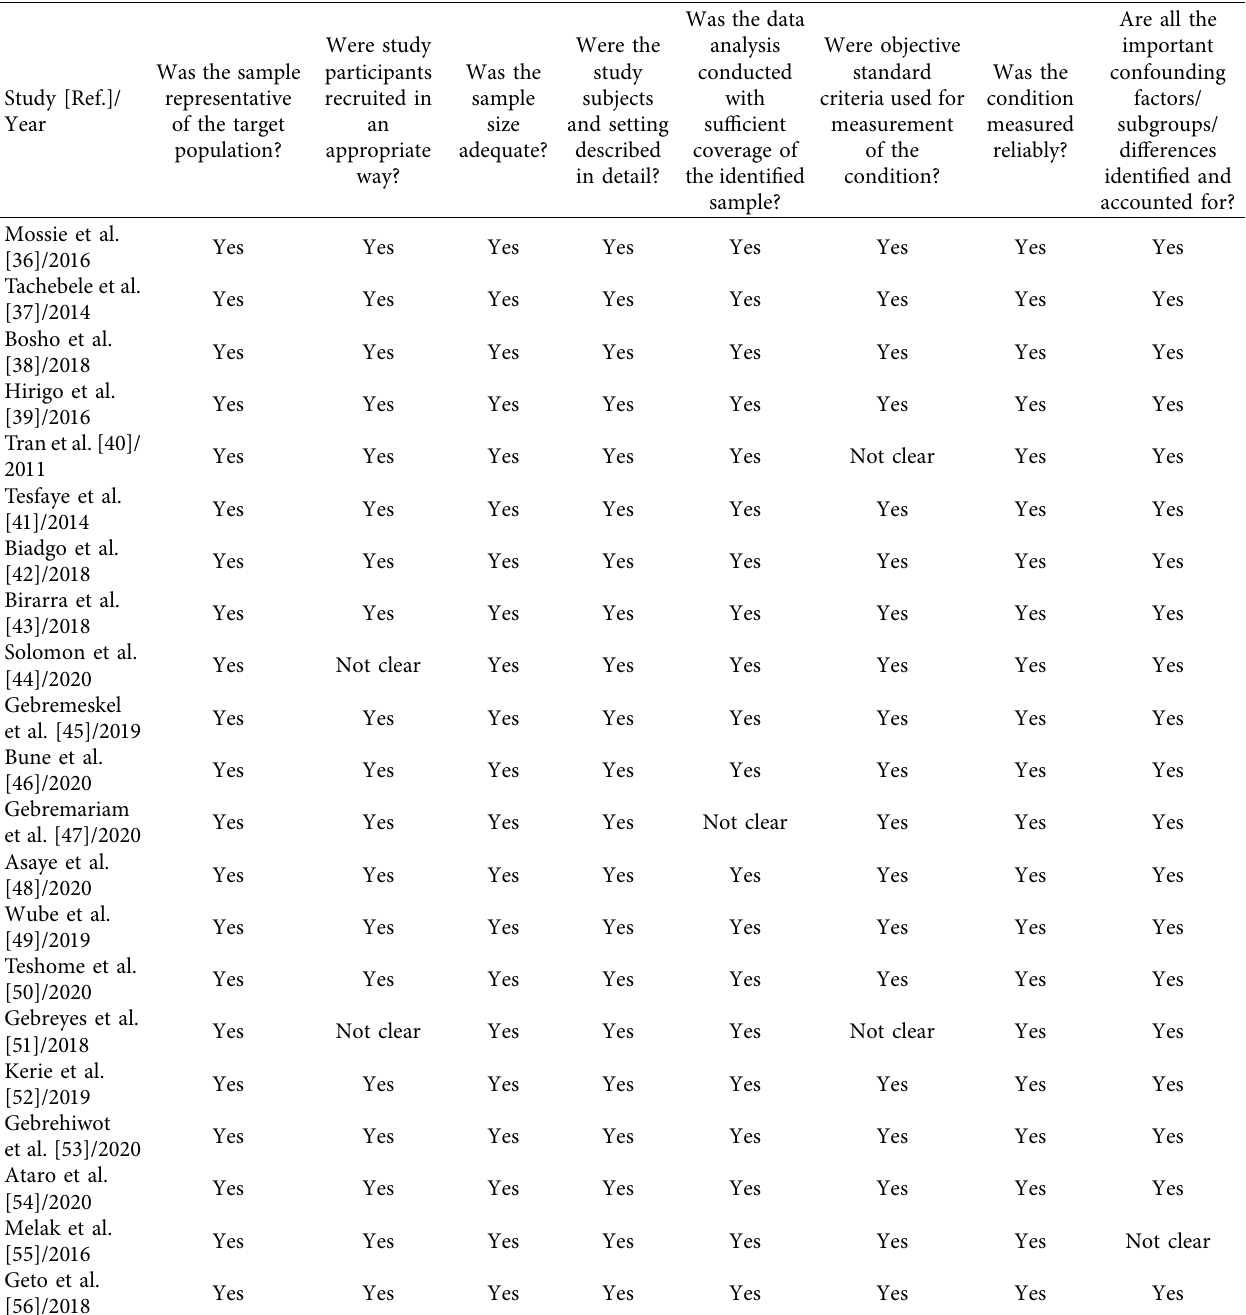
Table 2: Methodological quality assessment of included studies using Joanna Brigg’s Institute quality appraisal criteria scale (JBI).